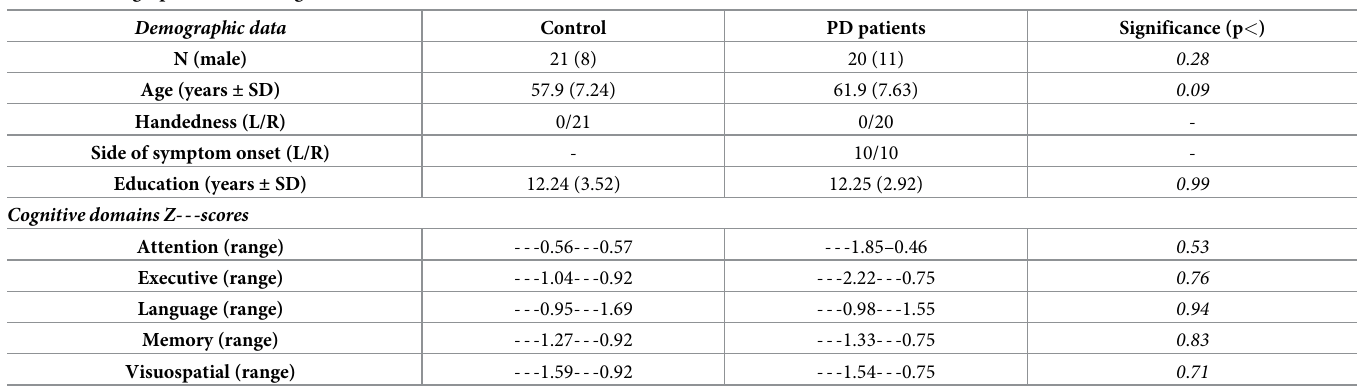
Table 1. Demographic data and cognitive